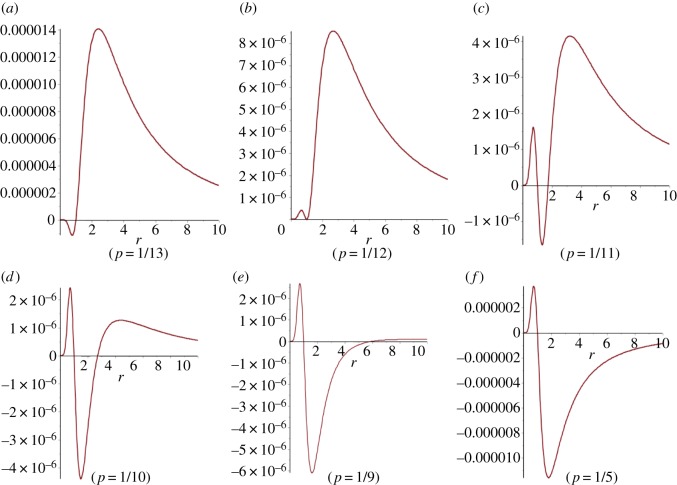
Cross sections of figure 10e.